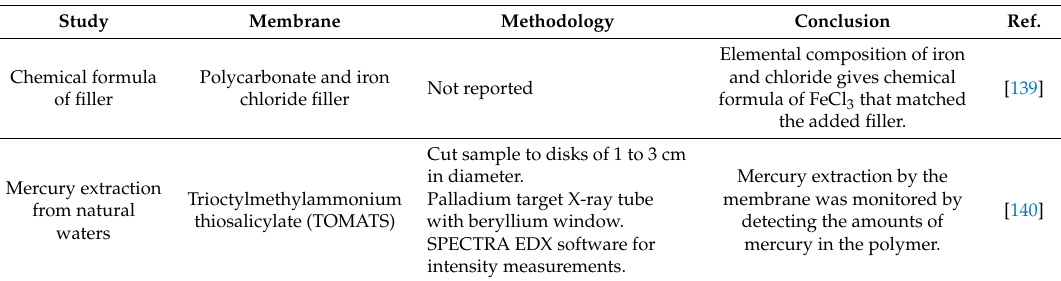
Figure 32. Identification of compounds using XRF by radioactive cadmium [139]. Table 11. XRF studies for membrane